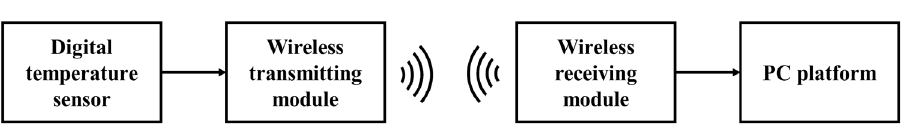
Figure 5. Constitution diagram of the mud cake temperature monitor system for TBM cutterhead.